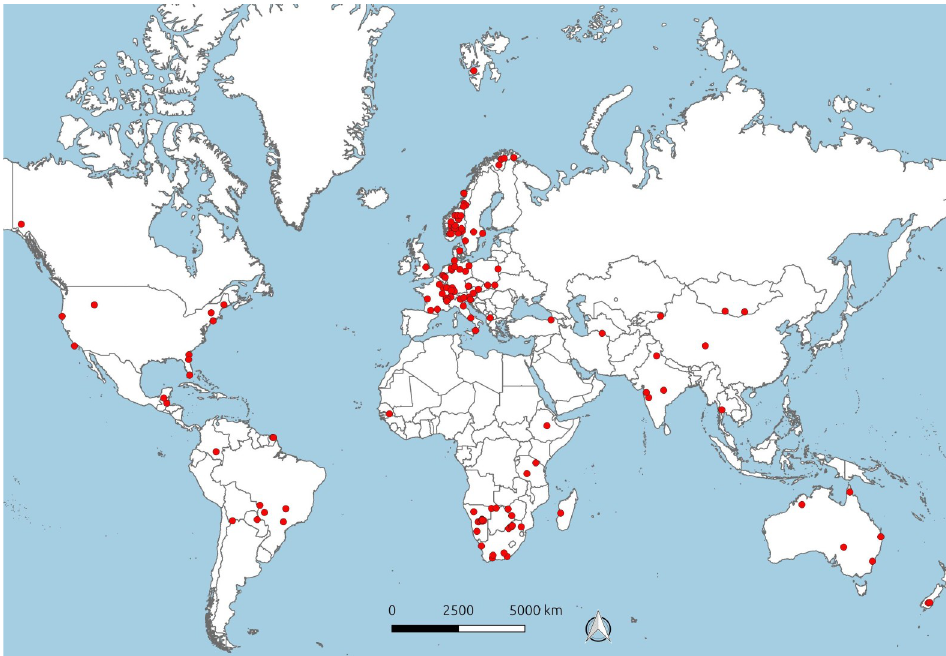
Fig 2. Project distribution. The geographic distribution of all projects that provided information on the performance of satellite telemetry units. Note that each red dot can comprise more than one project.